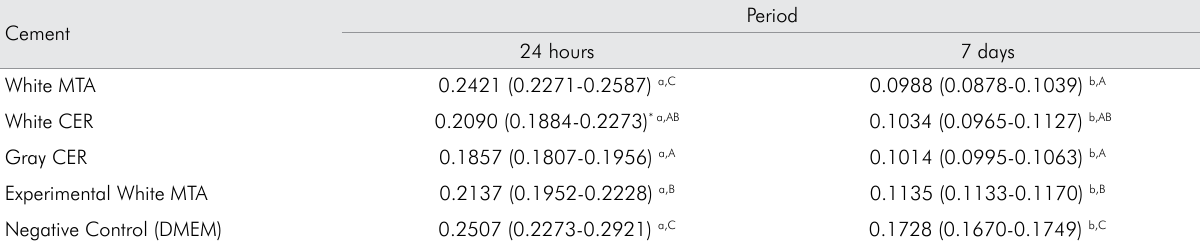
Table 2. Mean values of succinate dehydrogenase enzyme (SDH) production by cells exposed to the cement extracts (24 hours or 7 days) or to